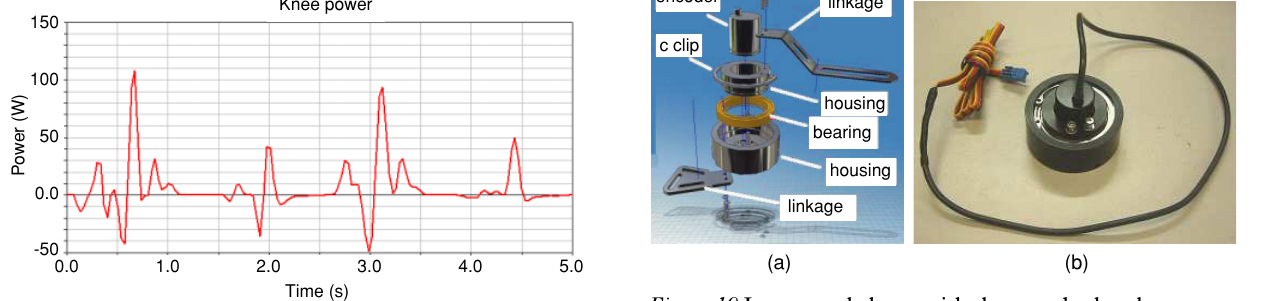
Figure 16 Knee instantaneous mechanical power.